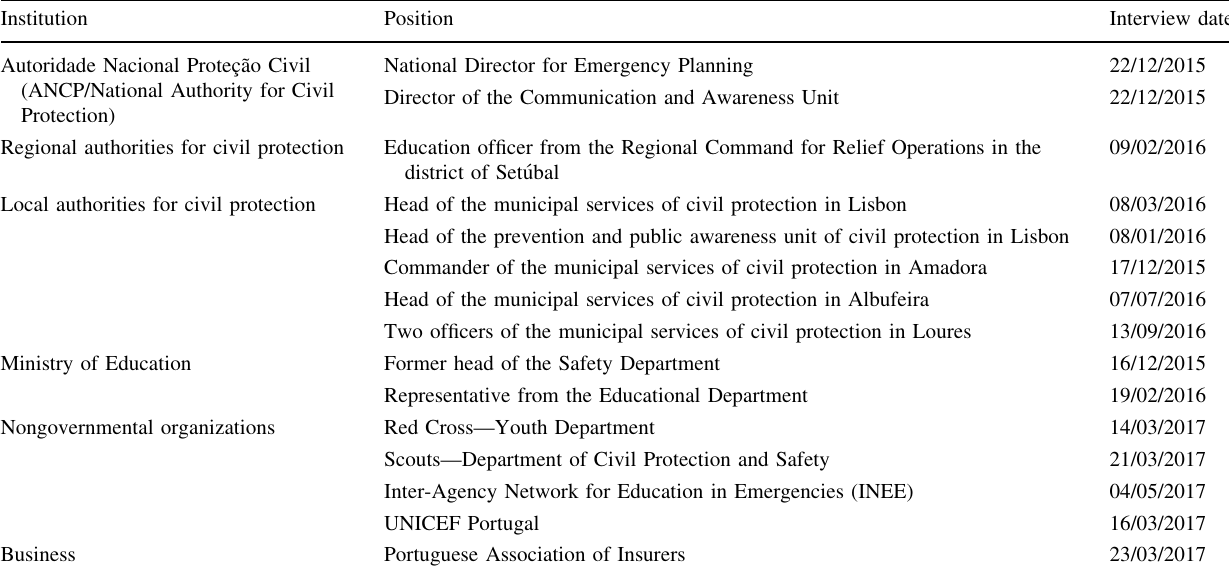
Table 1 Interviews with key informants on the participation of children in disaster risk reduction in Portugal